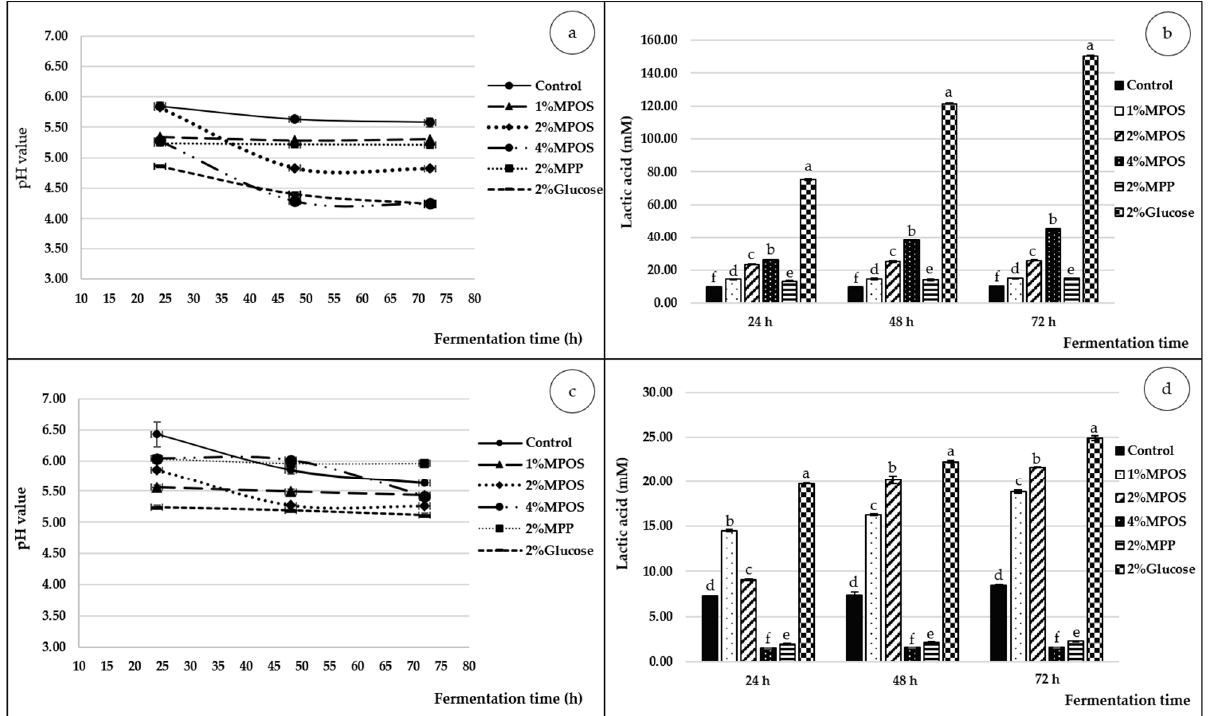
Figure 4. pH and lactic acid of L. reuteri DSM 17938 ( a , b ) and B. animalis TISTR 2195 ( c , d ) cultivated in media supplemented with different carbon sources for 72 h of fermentation time. Different letters on the bars in the same fermentation time indicate statistically significant differences ( p < 0.05).